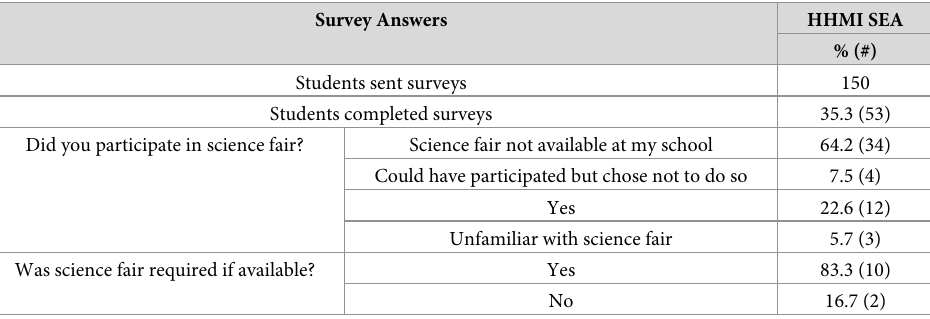
Table 6. HHMI SEA student participation in high school science